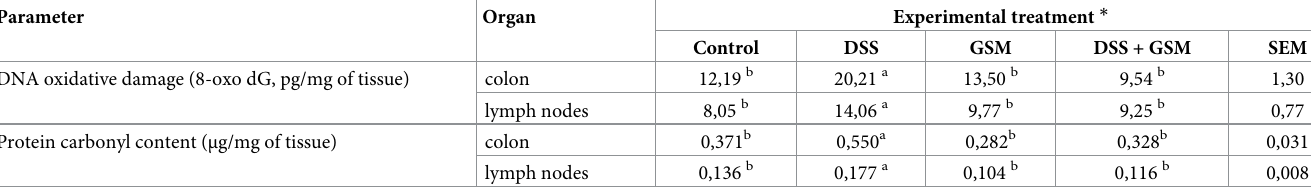
* Unchallenged and DSS-treated pigs were assigned for 30 days to a control diet (Control and DSS groups) or 8% GSM diet (GSM and DSS + GSM groups). At the end of the experiment, colon and lymph nodes samples from all animals (n = 5) were collected and analysed for DNA oxidation and protein carbonyl content). The results are presented as means. a,b = values with unlike superscript letters were significantly different ( p <